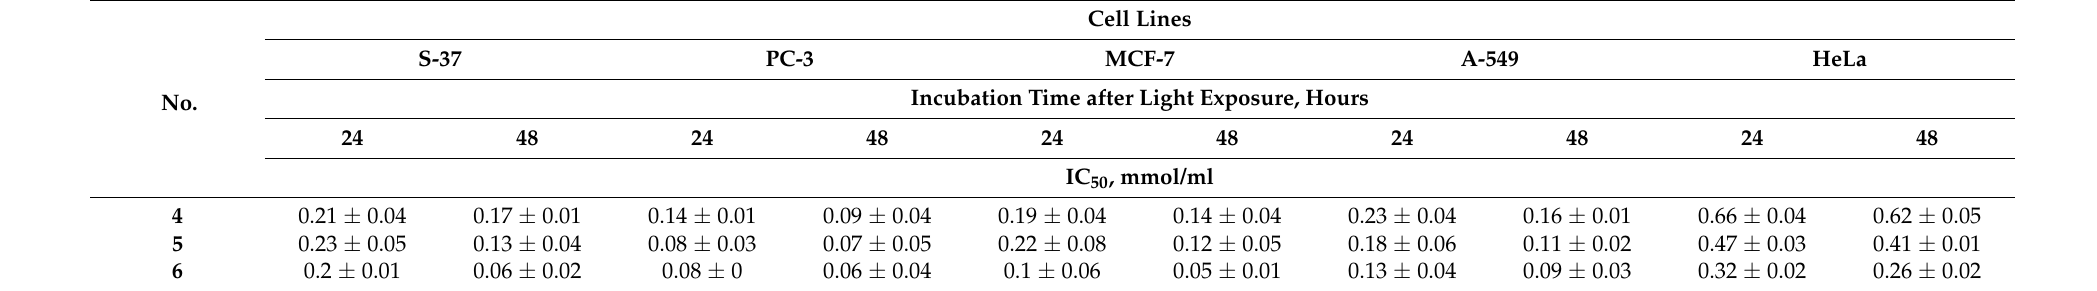
Table 3. Results of the photoinduced cytotoxicity